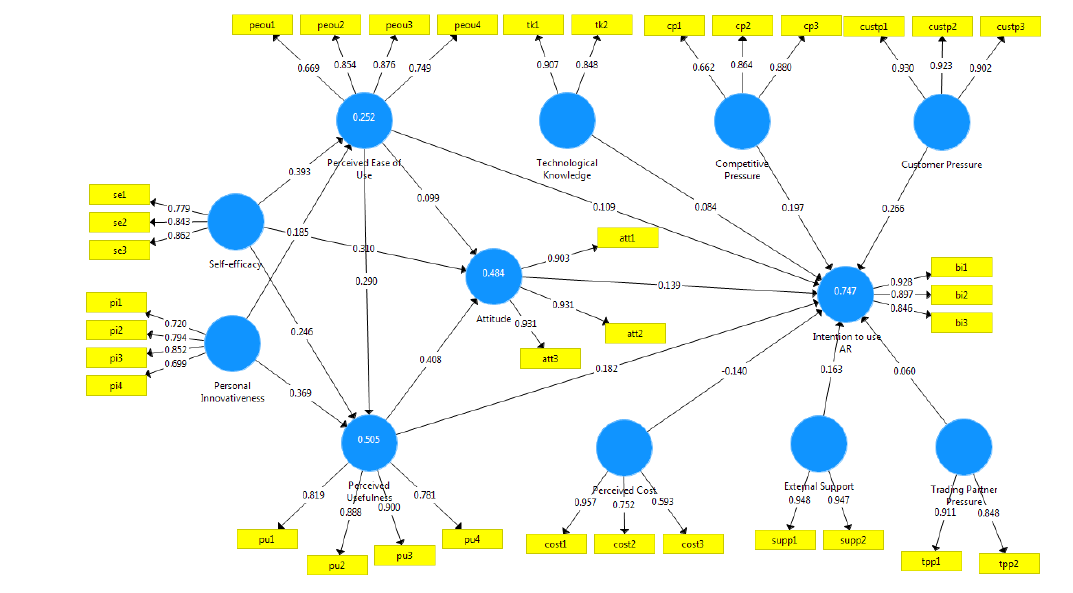
Figure 2. Measurement model. Table 1. Factor loadings and reliability statistics.